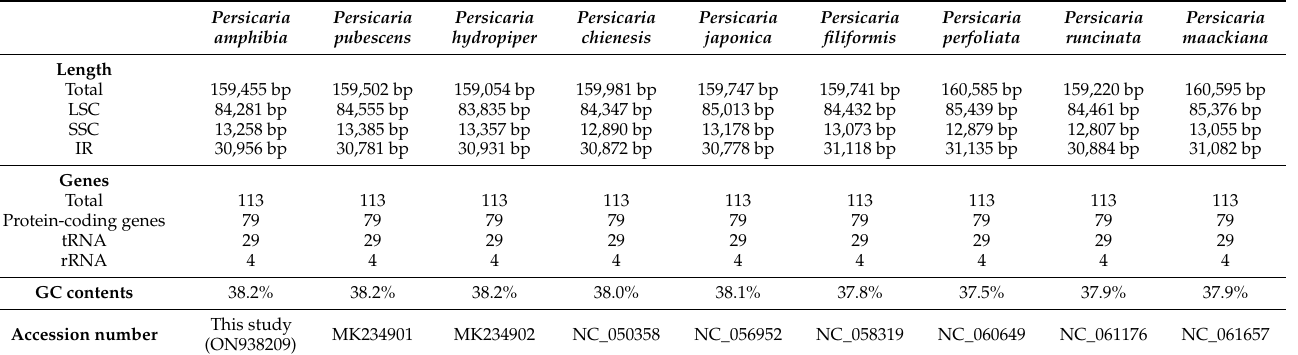
Table 1. Comparison of features of nine Persicaria cp